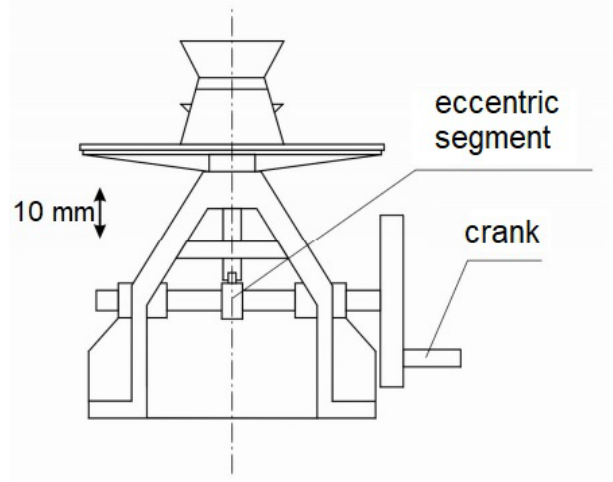
Figure 3. Manual flow table.